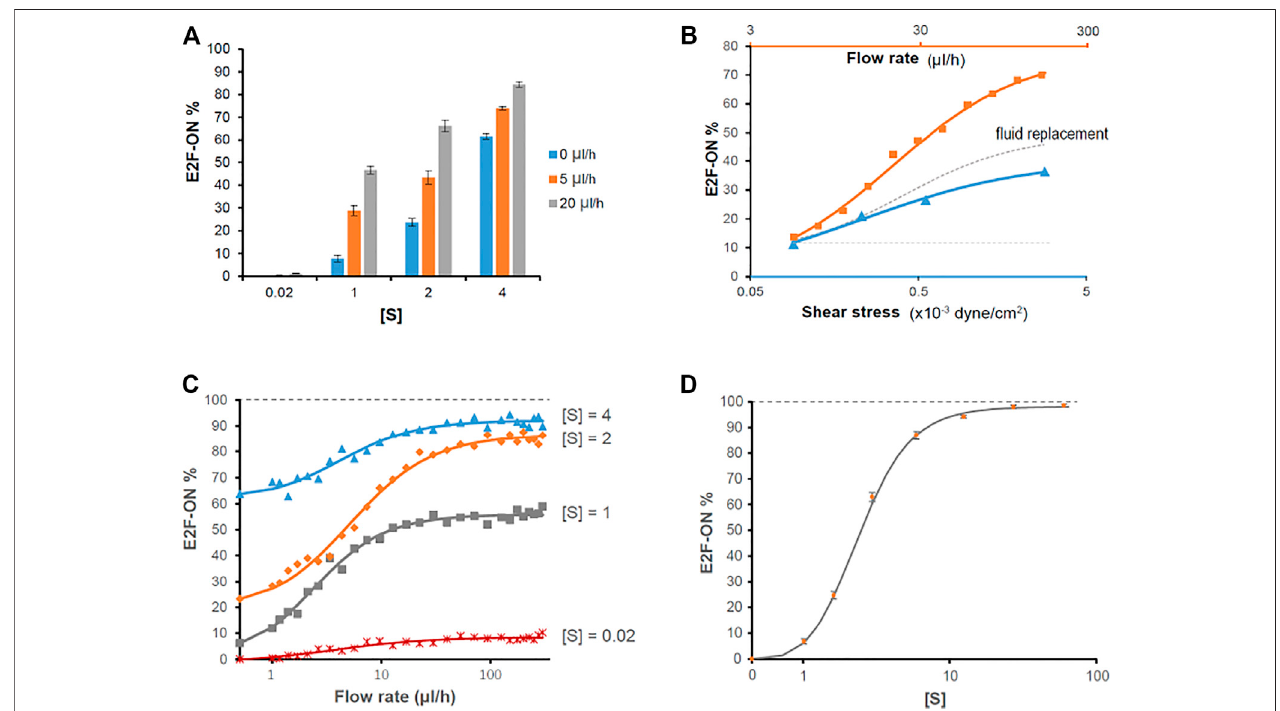
FIGURE 6 | Simulation results on the effects of extracellular fl uid fl ow on quiescence depth. (A, C, D) Simulated cell responses to serum stimulation using the fl uid fl ow-incorporated Rb-E2f bistable switch model. Serum starvation-induced quiescent cells, under the in fl uence of extracellular fl uid fl ow at the indicated rates (A, C) or without fl uid fl ow (D) ,werestimulatedwithserumatindicatedconcentrations[S].TheaverageE2f-On%from fi vesetsofstochasticsimulations(200runseach)isshown for each condition. Errorbars inA and D,SEM ( n =5). (B) The effects of fl uid fl owrate(orange),mechanical shear stress(blue), and extracellular factor replacement (gray)on quiescencedepth. Bluetriangle,the averageE2f-On% inresponseto2%serum stimulation,in cellsunder5 ul/hextracellular fl uid fl ow withtheindicatedshear stress level during serum starvation (based on Figure 4A and Table 1 ). Orange square, the average E2f-On% calculated from fi ve sets of stochastic simulations in response to 2% serum stimulation under the in fl uence of the indicated fl uid fl ow rate. Parameters used in this simulation ( θ = 0.3, δ = 32) were determined to fi t the simulatedE2f-On%totheexperimentalresultsshownin Figure4A (at5 ul/hmedium fl owratewith0 mg/mldextran).Thevaluesof fl owrateintheorangecurveandthe corresponding values of shear stress in the blue curve are related base on Eq. 1 . The dotted gray curve represents the “ delta ” between the orange and blue curves; the dotted horizontal line is for the guide of eye extending from the initial data point (5 ul/h). (B – D) Each solid curve represents the best fi t of data points to a Hill function.